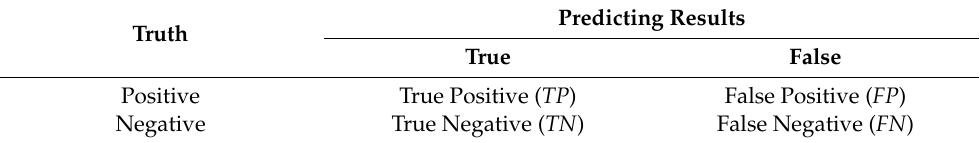
Table 1. Confusion matrix of binary